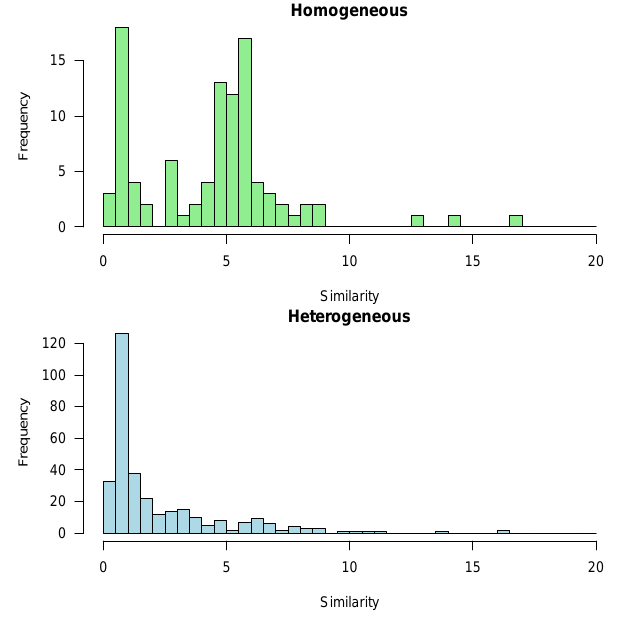
Figure 8. Histogram of similarities of total carbonate mineralisation in the homogeneous and heterogeneous cases.